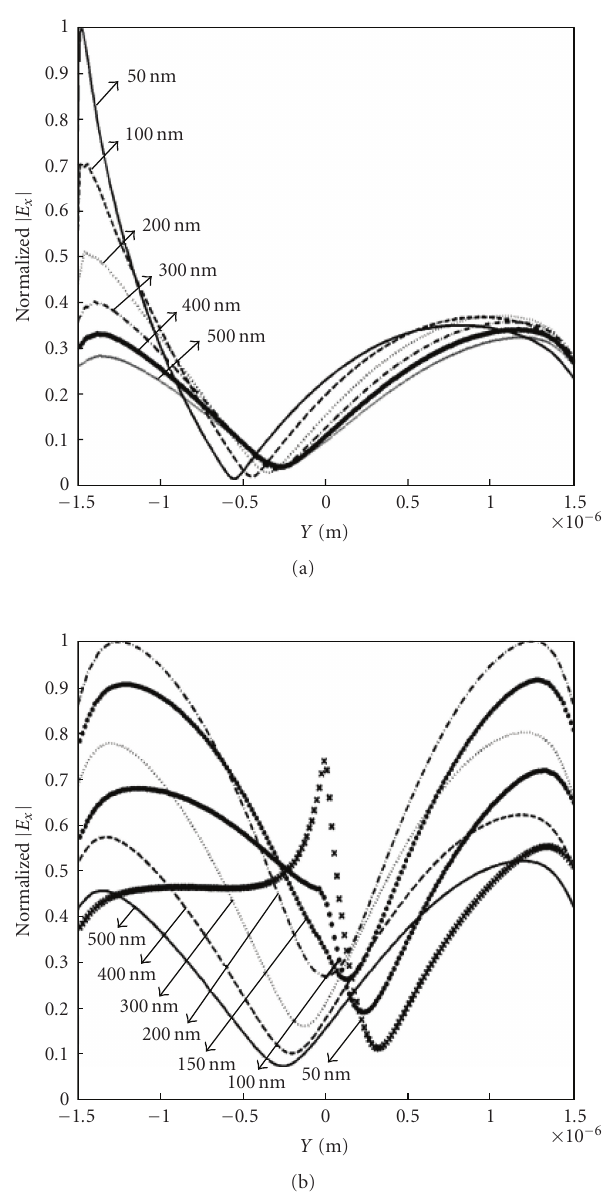
Figure 5: Normalized electric field x -component ( | E x | ) at an inci- dent wavelength of 6.35 μ m along the channel center line of a gold grating in vacuum with (a) converging channel and (b) CDC for di ff erent gaps at the throat and grating parameters as d = 3.5 μ m, a = 0.5 μ m, and t = 3.0 μ m.